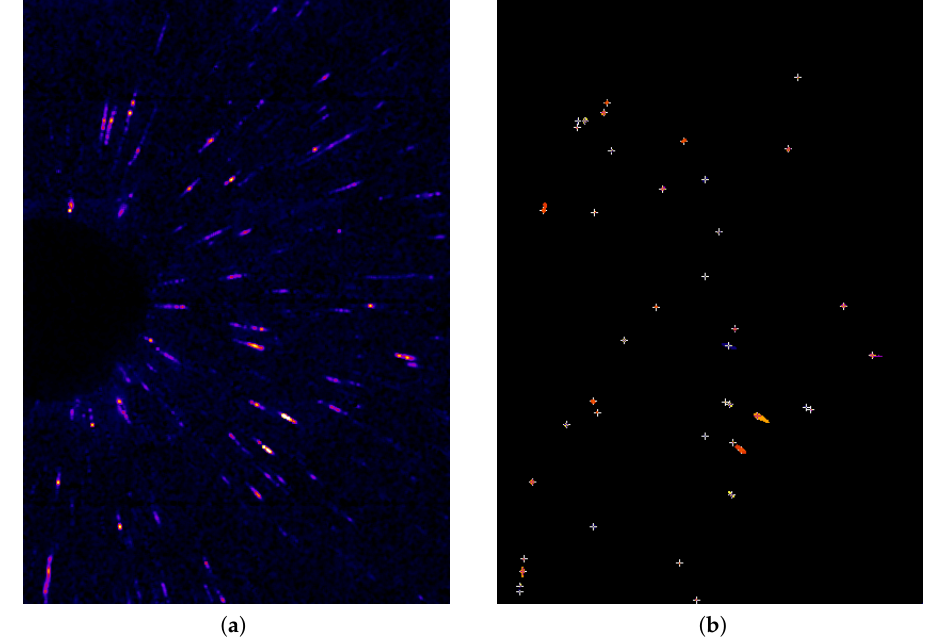
Figure 10. Diffraction image and peak positions with an X-ray energy of 68 keV. ( a ) Diffraction image calculated by the difference between threshold X-ray energy; ( b ) peak positions indicated by a